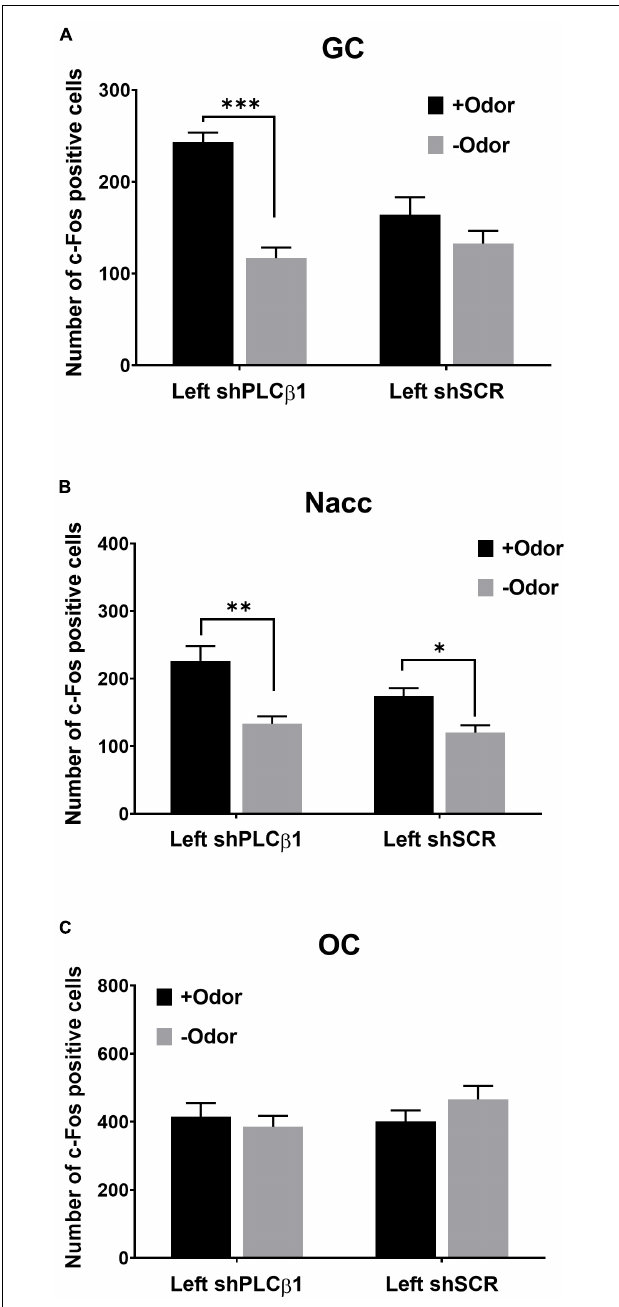
FIGURE 5 | Patterns of CS-evoked neural activation in the left mPFC shPLC β 1- or shSCR-injected mice that received extended training (4Days). Number of c-Fos-positive cells after the exposure to +Odor (black) or –Odor (gray) in the GC (A) , the Nacc (B) , and the OC (C) of left shPLC β 1- or left shSCR-injected mice that received extended training. Numbers of mice ( N ) and sections ( n ): (A) (shPLC β 1 +Odor, N = 3, n = 9; shPLC β 1 –Odor, N = 3, n = 9; shSCR +Odor, N = 3, n = 9; shSCR –Odor, N = 3, n = 9), (B) (shPLC β 1 +Odor, N = 3, n = 9; shPLC β 1 –Odor, N = 3, n = 9; shSCR +Odor, N = 3, n = 9; shSCR –Odor, N = 3, n = 9), (C) (shPLC β 1 +Odor, N = 3, n = 9; shPLC β 1 –Odor, N = 3, n = 9; shSCR +Odor, N = 3, n = 9; shSCR –Odor, N = 3, n = 9). All the values are mean ± SEM. ∗ p < 0.05; ∗∗ p < 0.01; *** p <